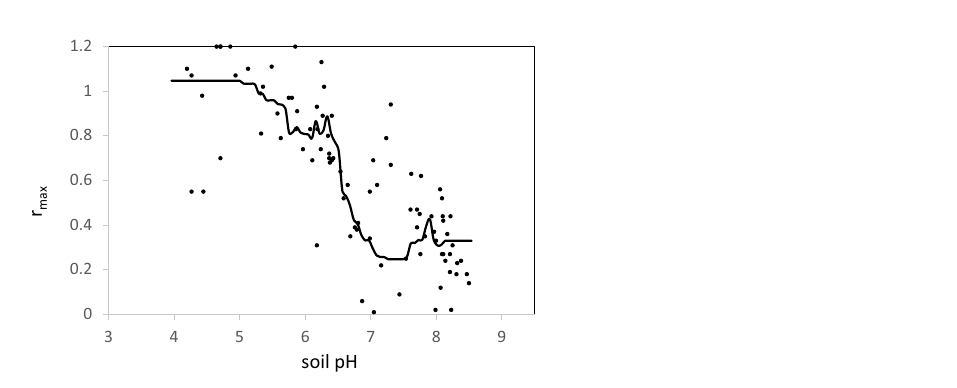
Figure 1. The capacity of soils to reduce N 2 O, expressed as the r max indicator and shown on the RMQS grid.